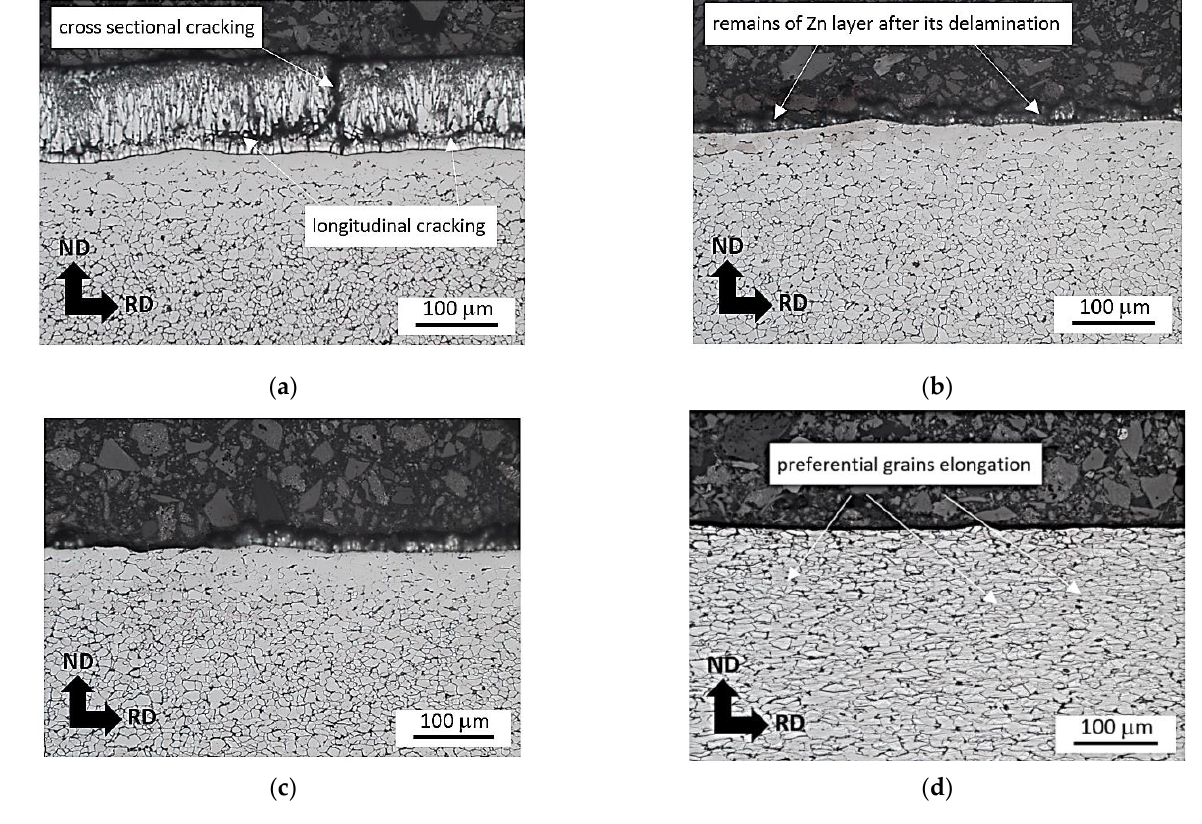
Figure 10. Metallographic images of the matrix and delamination of Zn layer during tensile test as a function of plastic strain for strain rate 0.5 × 10 −3 s −1 . ( a ) ε = 5.0%, ( b ) ε = 11.8%, ( c ) ε = 18.7%, ( d ) ε = 32.5%.